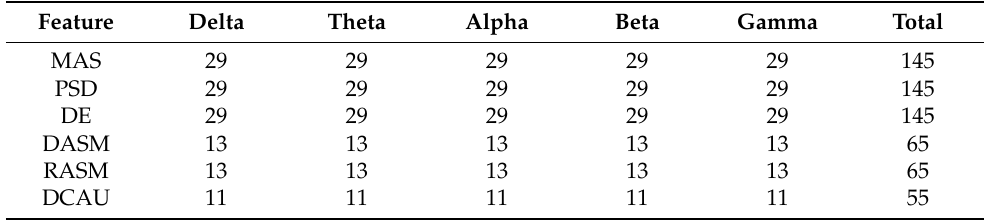
Table 1. Dimensions of each EEG feature.